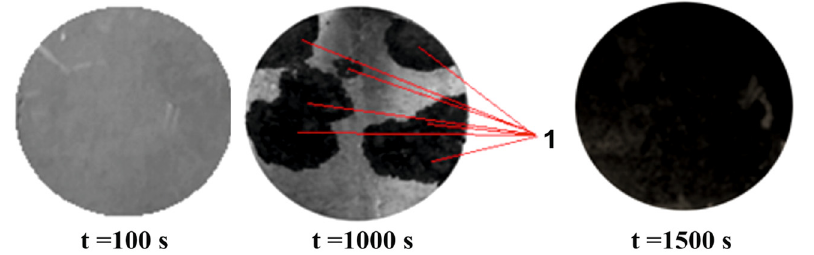
Figure 2. The development of corrosion on the surface of a smooth (non-textured) substrate under a droplet of salt solution.